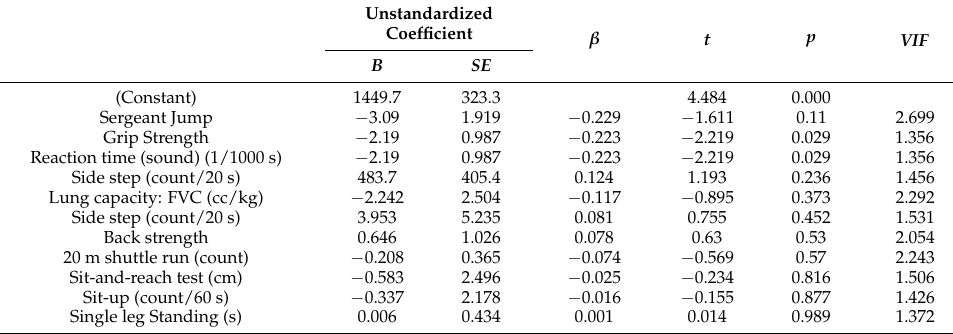
Table 7. The effect of basic fitness factors on overall performance.